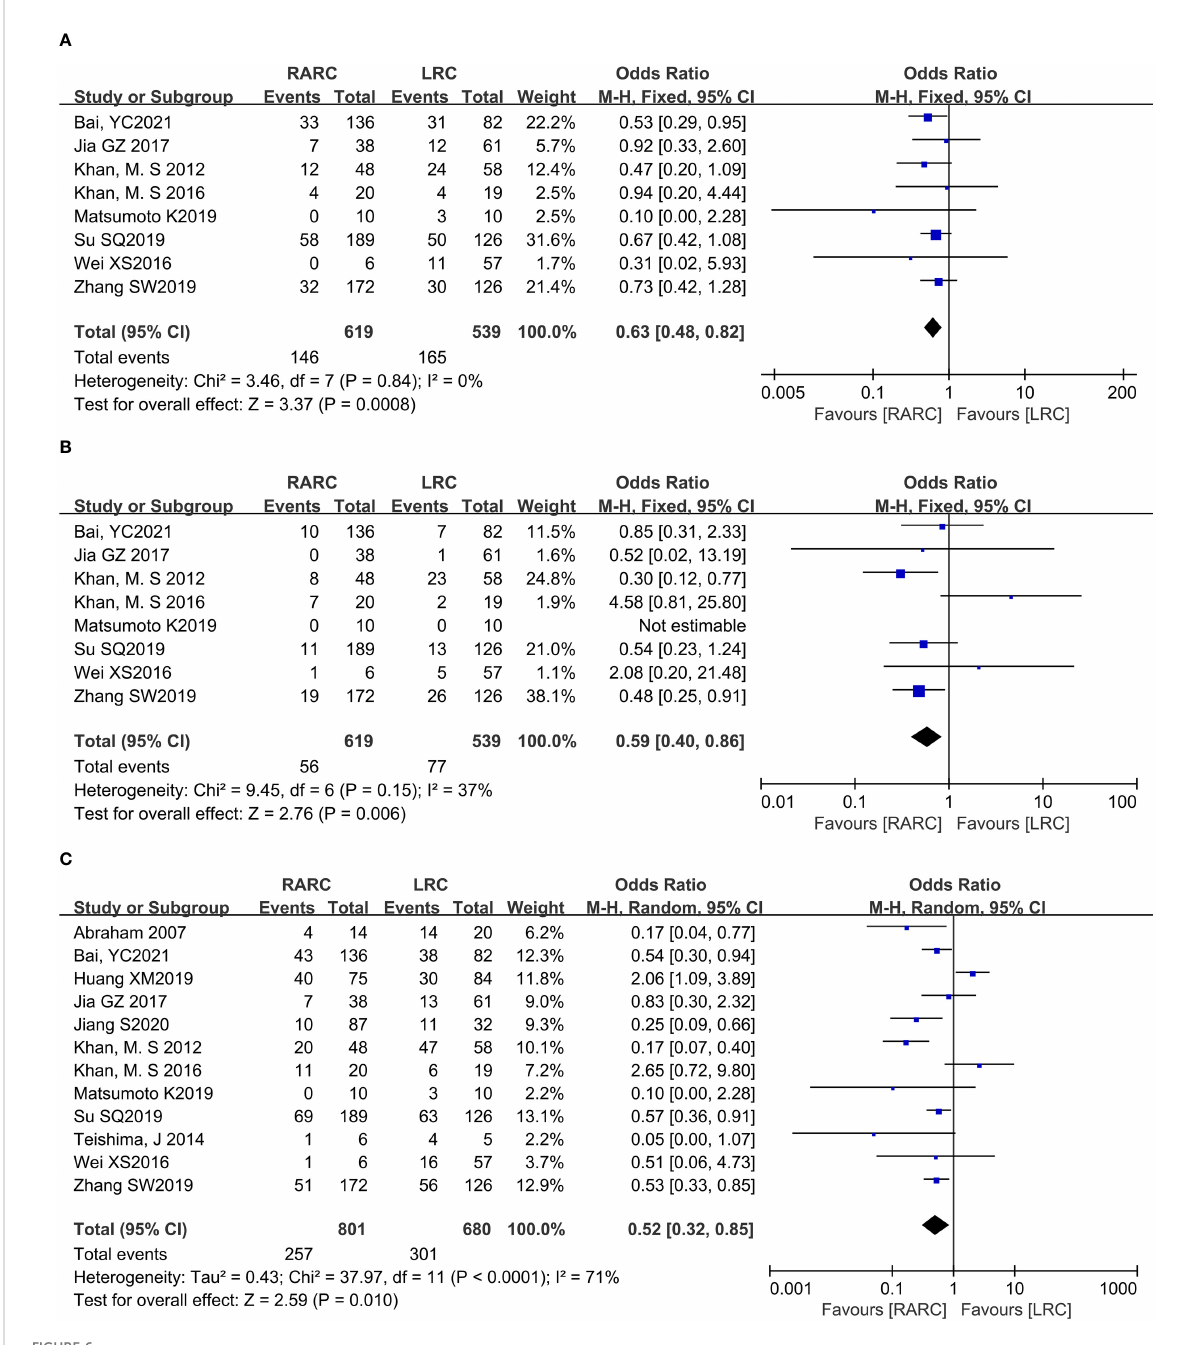
signi fi cant difference in lymph node yield, positive surgical margins, operating time, transfusion rate, length of stay and days to regular diet between the two groups